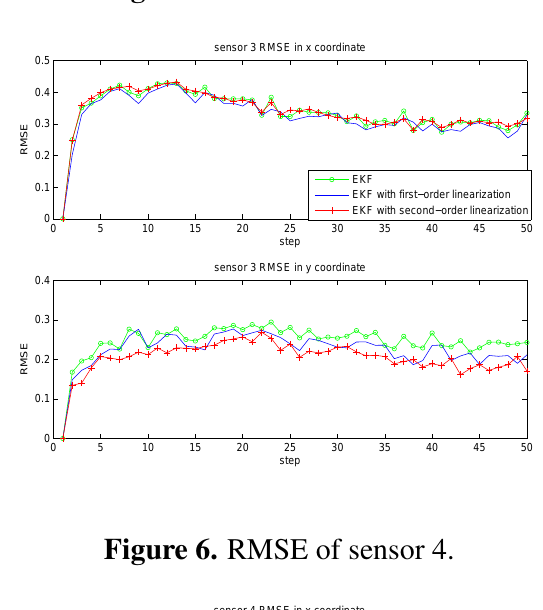
Figure 5. RMSE of sensor 3.